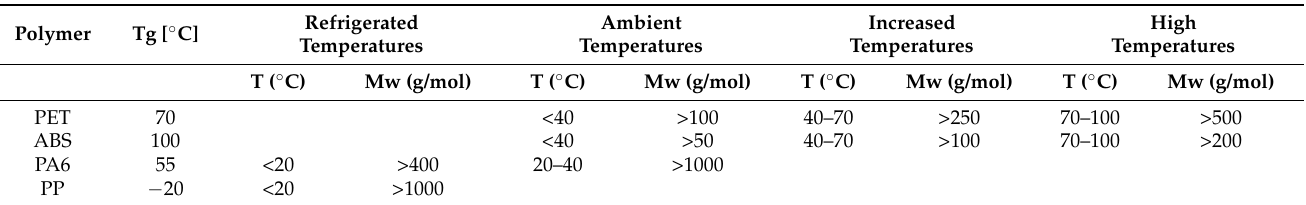
Table 1. Estimation of temperature and molecular weight ranges in which partitioning plays a minor role in short-term single-use food contact applications.